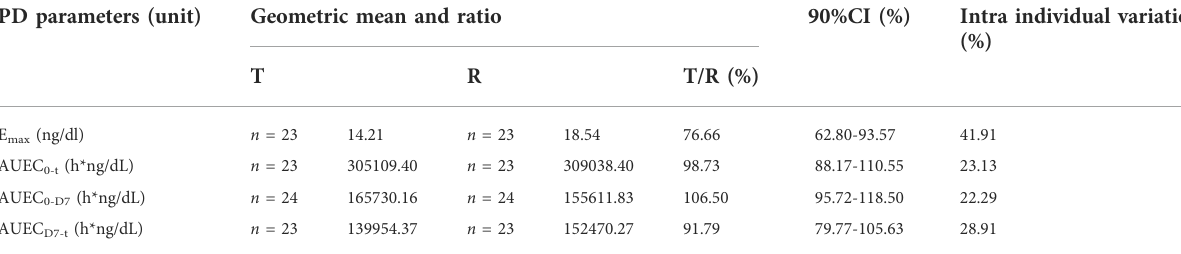
TABLE 3 Pharmacodynamic parameters of testosterone: Geometric mean ratio and 90% con fi dence interval. PD parameters